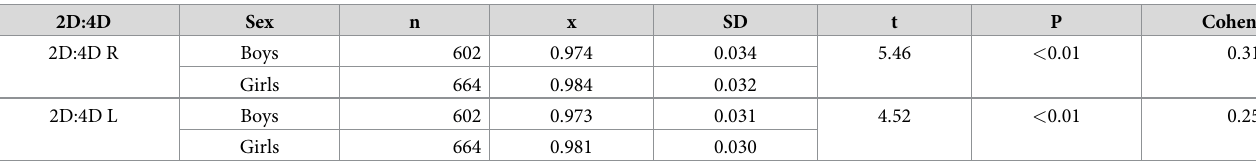
Table 3. Characteristics of 2D:4D in boys and girls and Cohen’s effect sizes.